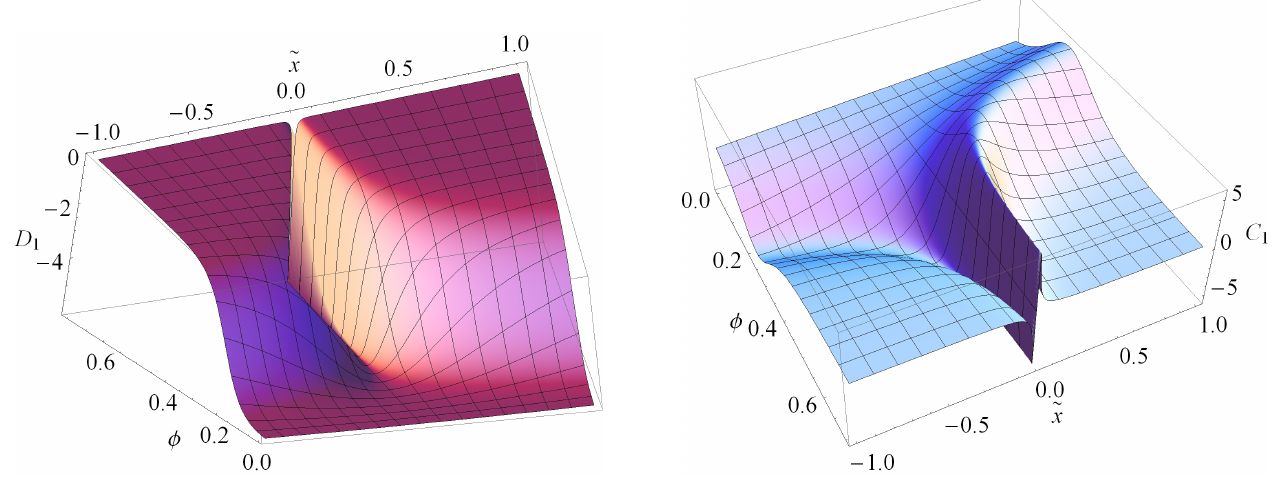
Figure 1. D 1 ( ˜ x , φ ) (left) and C 1 ( ˜ x , φ ) (right) as functions of two variables; lines of constant ˜ x correspond to orbits (19)–(21) of the affine group